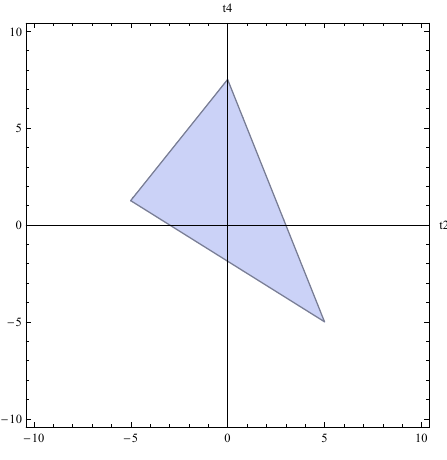
Figure 1 . The allowed domain for t 2 and t 4 in d = 4 conformal (cid:12)eld